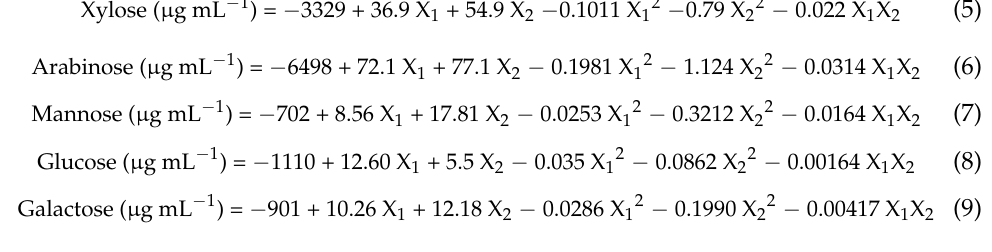
Table 13. Analysis of variance for xylose.